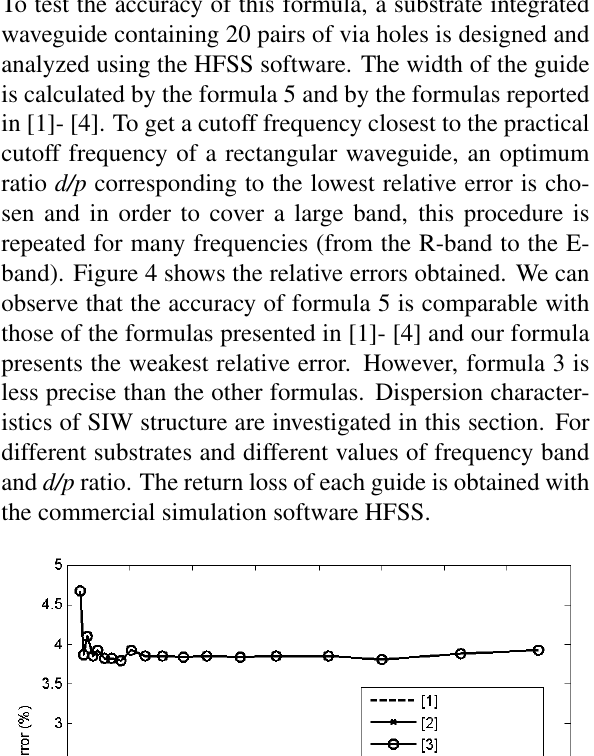
d d ) 2 − 0 . 068( )+1 . 0282) (10) p p